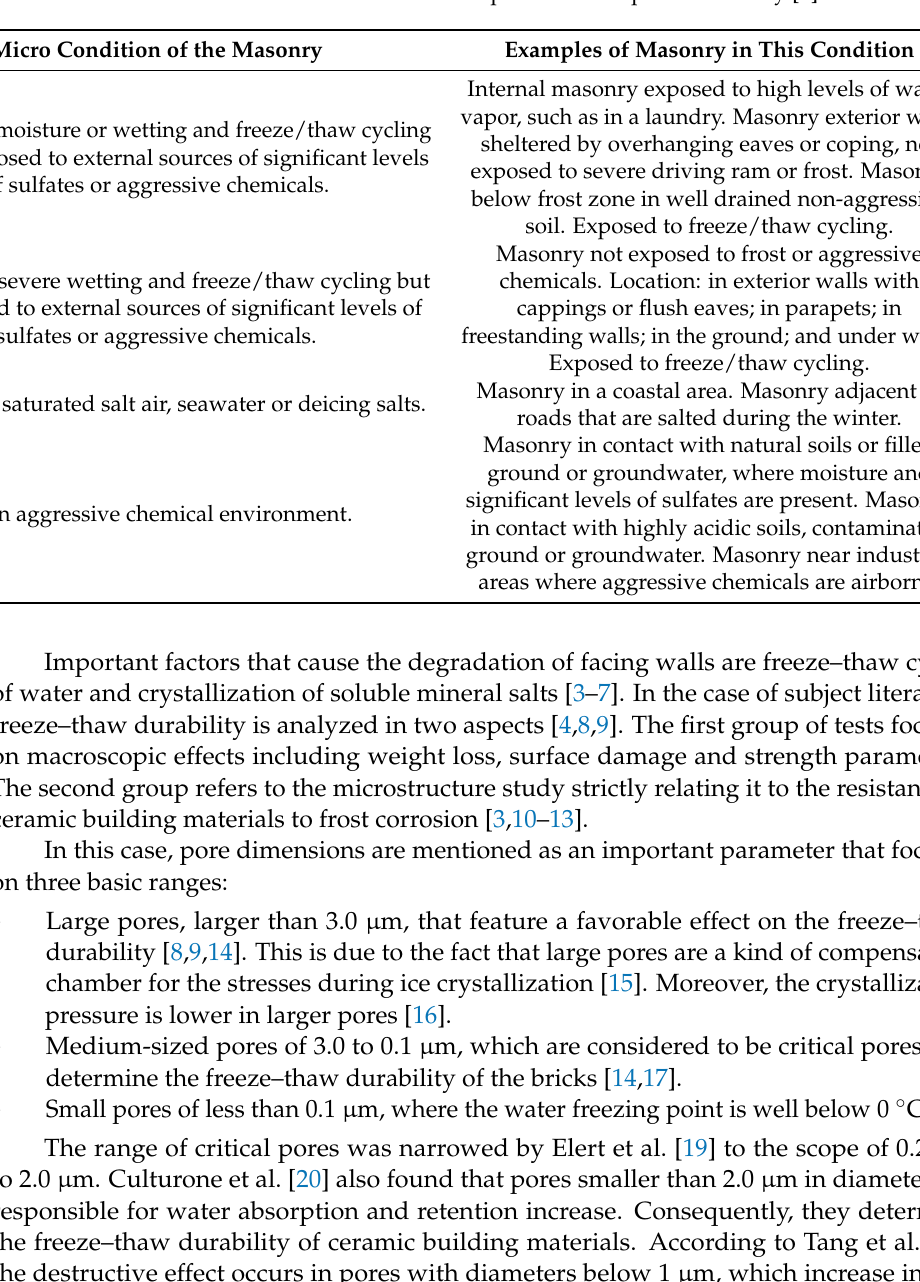
Table 1. Classification of the microconditions of exposure of completed masonry